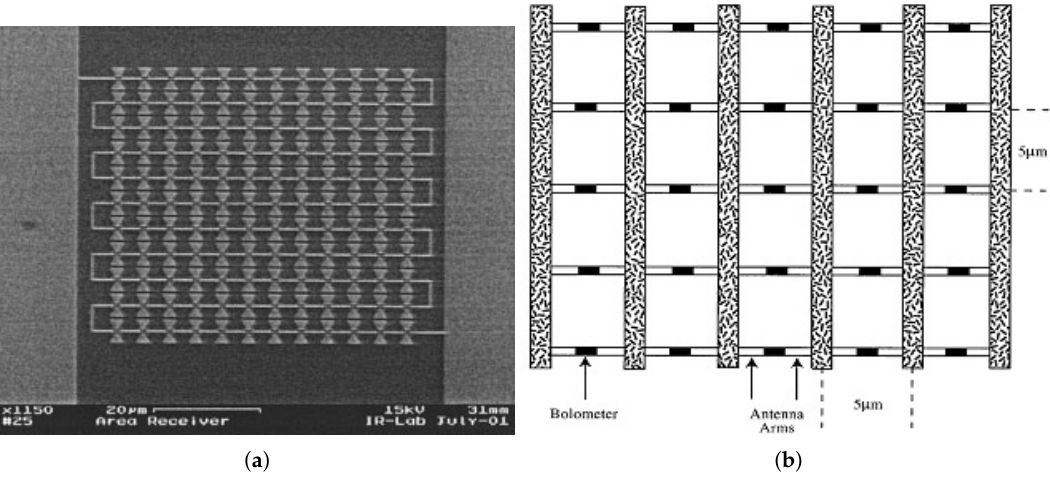
Figure 10. Effective collection area enhancement approaches: ( a ) Antenna array in serial configuration [39], ( b ) Antenna array in parallel configuration